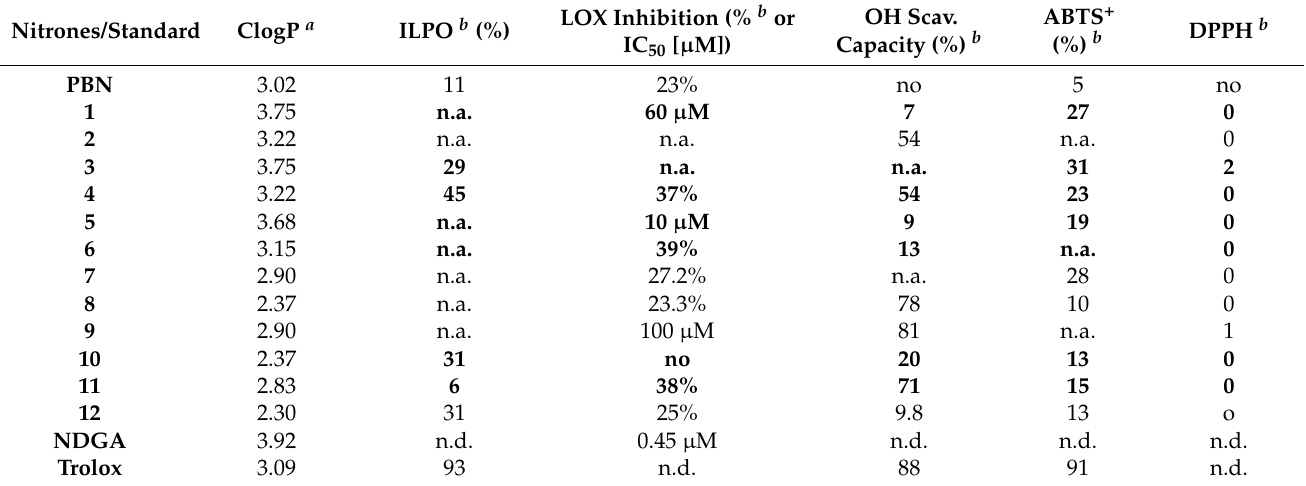
Table 1. Antioxidant activity of PBN -polyfunctionalized nitrones 1 – 12